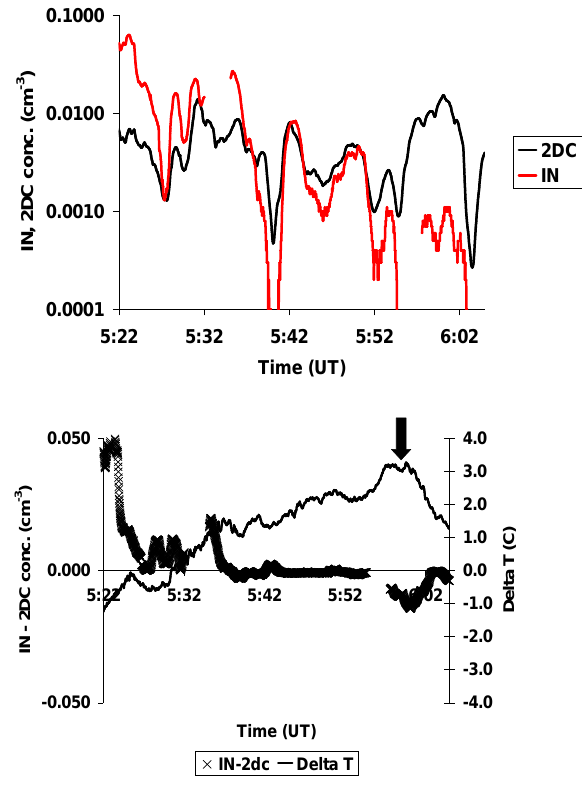
Fig. 5. (Top) Concentrations of ice particles measured by the 2DC and the simultaneous IN concentrations in the particle residuals be- tween 05:22 and 06:05UTC, which corresponds to the long black track segment in Fig. 1 (1Hz values smoothed by 60s running mean). (Bottom) The difference between the IN concentrations and the 2DC concentrations and the corresponding temperature dif- ference between the CFDC chamber and the ambient temperature (1Hz values). This pass was made at an altitude of 8.5km. The chamber temperature at 05:42 was − 25 ◦ C. The approximate loca- tion of the warm front is given by the